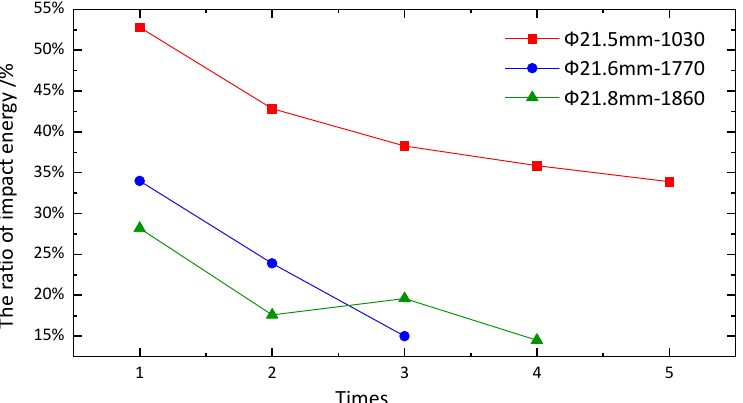
Figure 13. Impact times and impact energy ratio of cables.